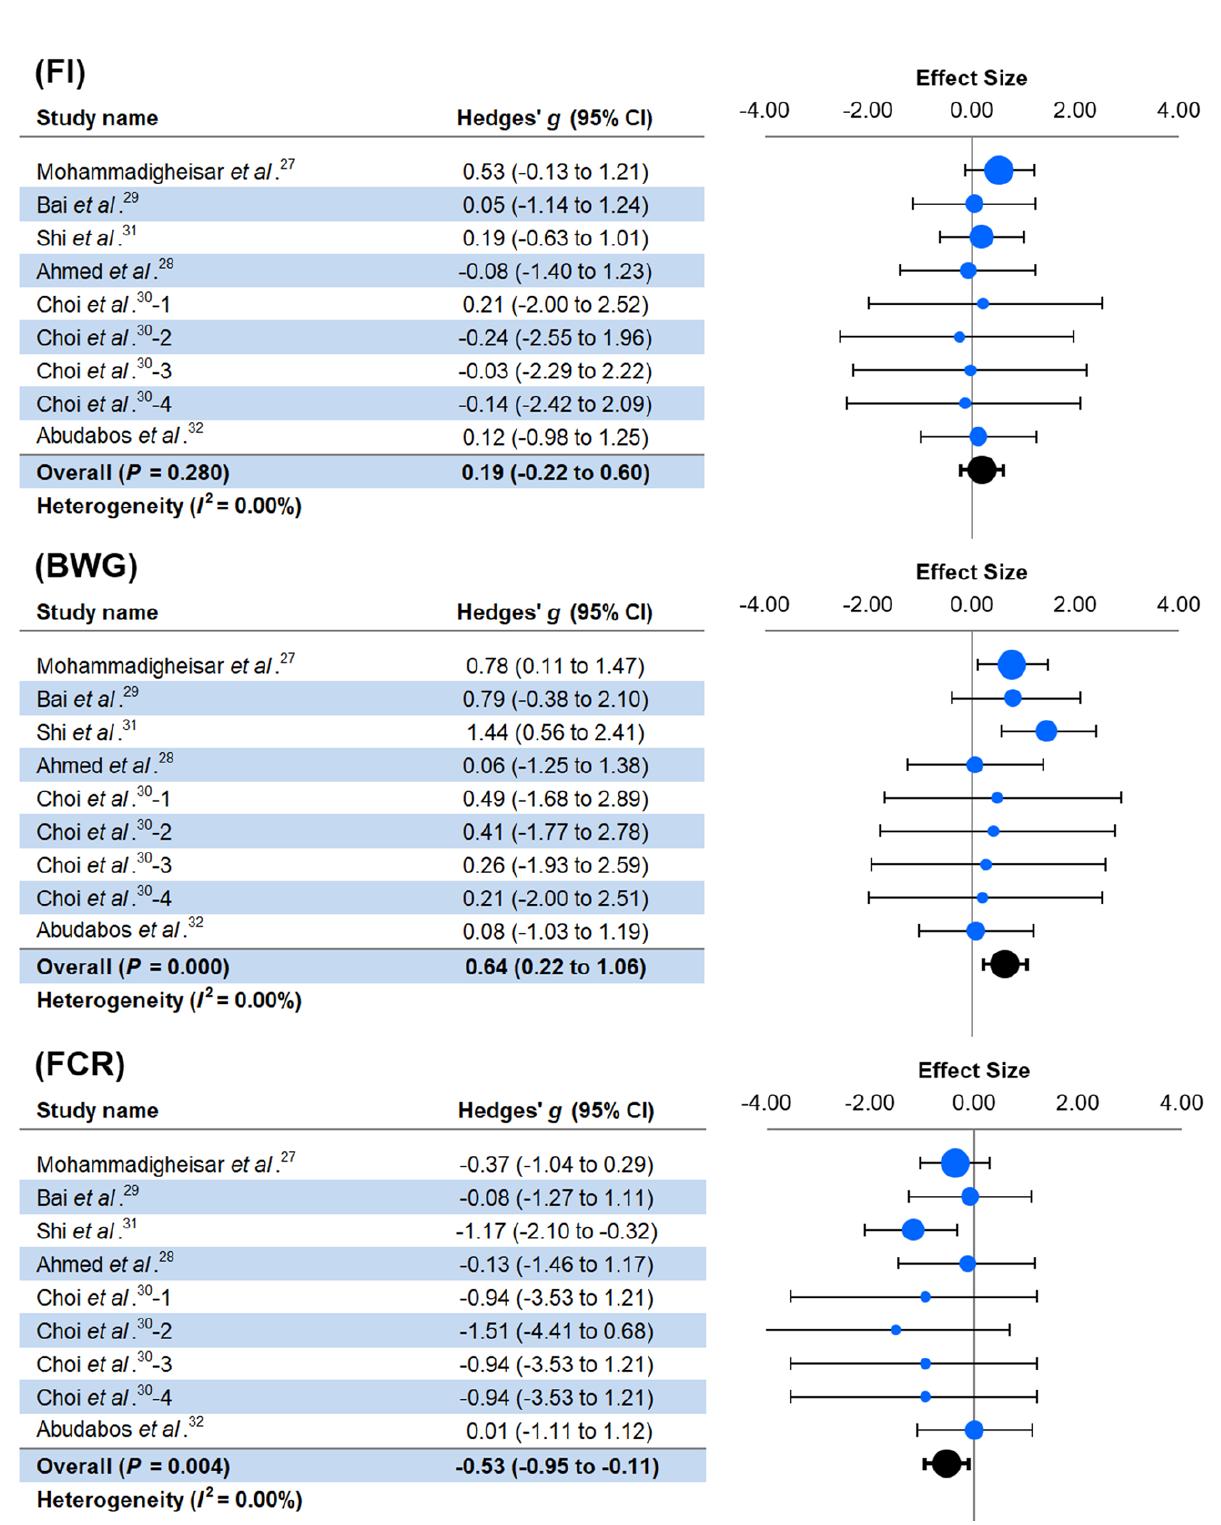
As shown in Figure 2, no substantial heterogeneity was found